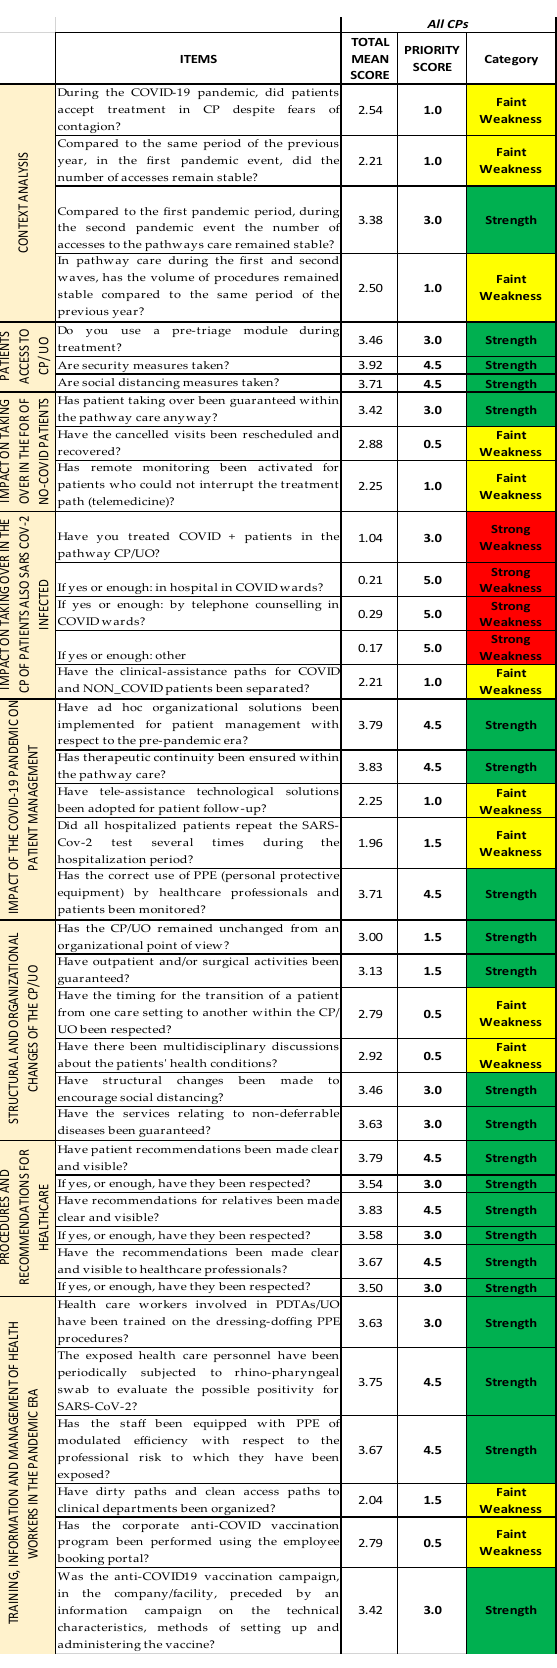
Figure 13. Summary of the results regarding all the items of all the CPs together.